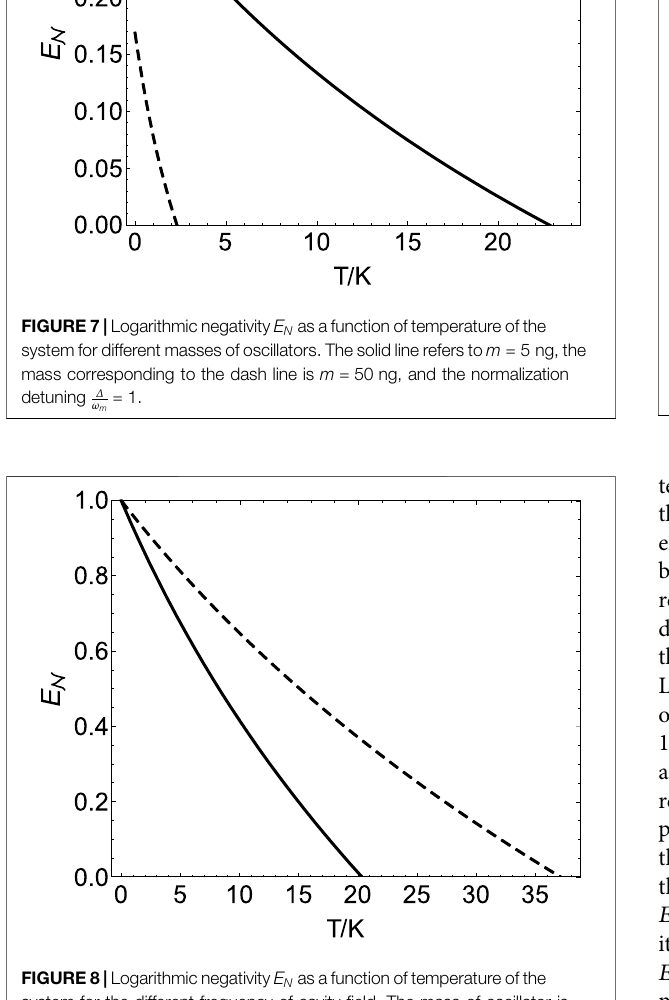
FIGURE8| Logarithmicnegativity E N asafunctionoftemperature ofthe system for the different frequency of cavity fi eld. The mass of oscillator is 10 ng, the normalized detuning is equal to 1. The dash line and solid line correspond to ω c (cid:1) 0 . 5 p ω 0 and ω c (cid:1) 1 p ω 0 , respectively.